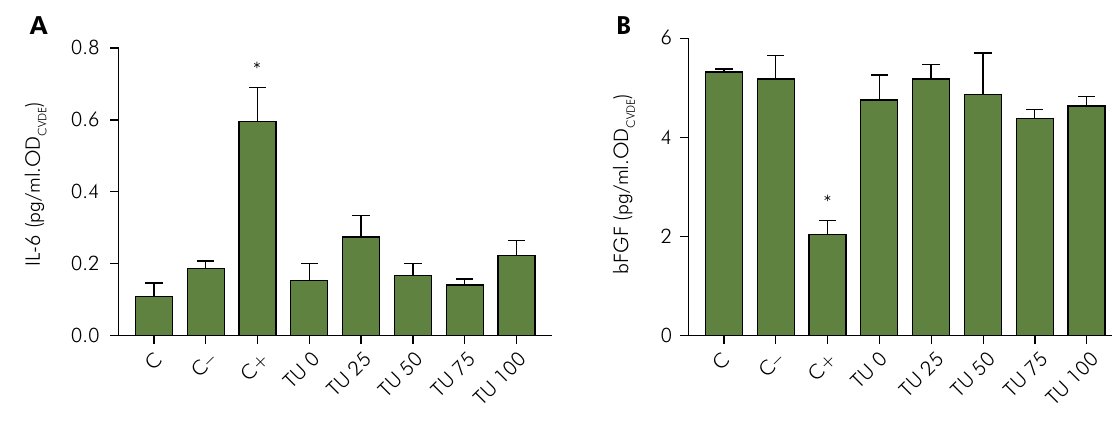
Figure 3. Evaluation of the release of IL-6 (A) and b-FGF (B) by HGF cells exposed to 24 hours extracts of the tested materials, or to a positive control (Latex, C+), or to a negative control (Polystyrene beads, C-). The results from the ELISA assay for cytokines (pg/ ml) was normalized by the cell density obtained with a CVDE assay performed in the same cells. The asterisk indicates significant difference from all other groups (p <